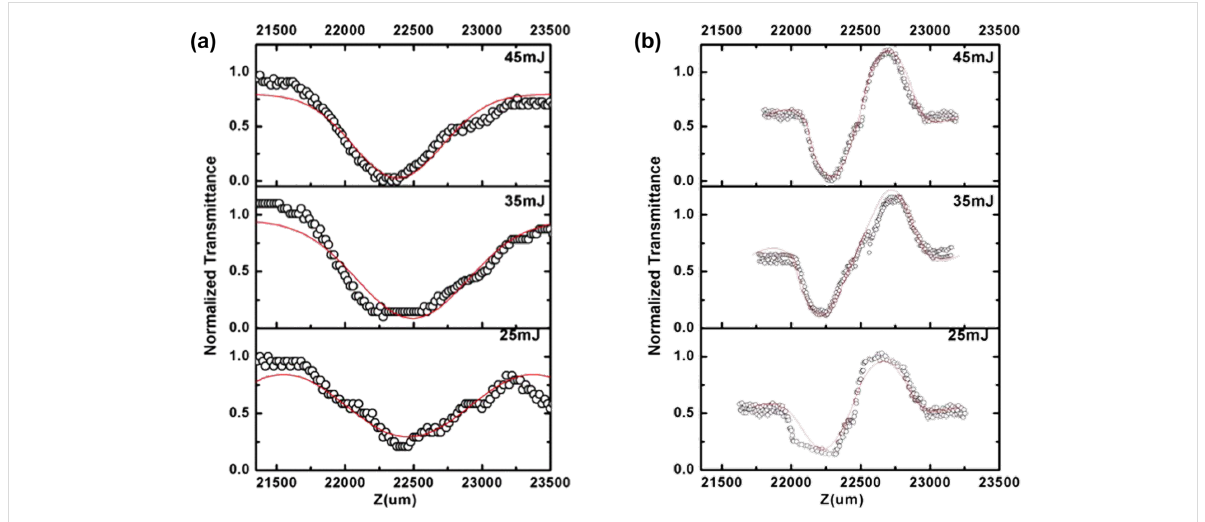
Figure 4: (a) Open-aperture Z -scan graph of Ag 2 S QDs; (b) closed-aperture Z -scan graph of Ag 2 S QDs.